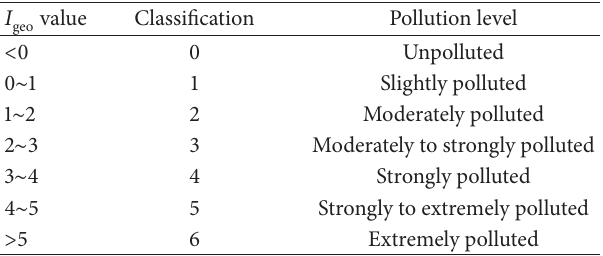
Figure 1: Map of the study area and sampling sites in TGR. Table 1: Geoaccumulation Index and classification of pollution